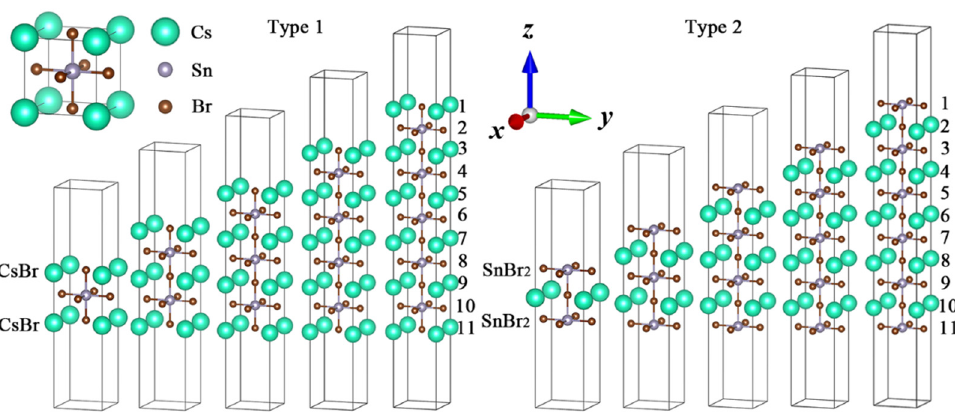
Figure 1. Surface models of ultrathin CsSnBr 3 perovskites: ( left ) CsBr termination for Type 1 and ( right ) SnBr 2 termination for Type 2. The top left corner is a model of bulk CsSnBr 3 .